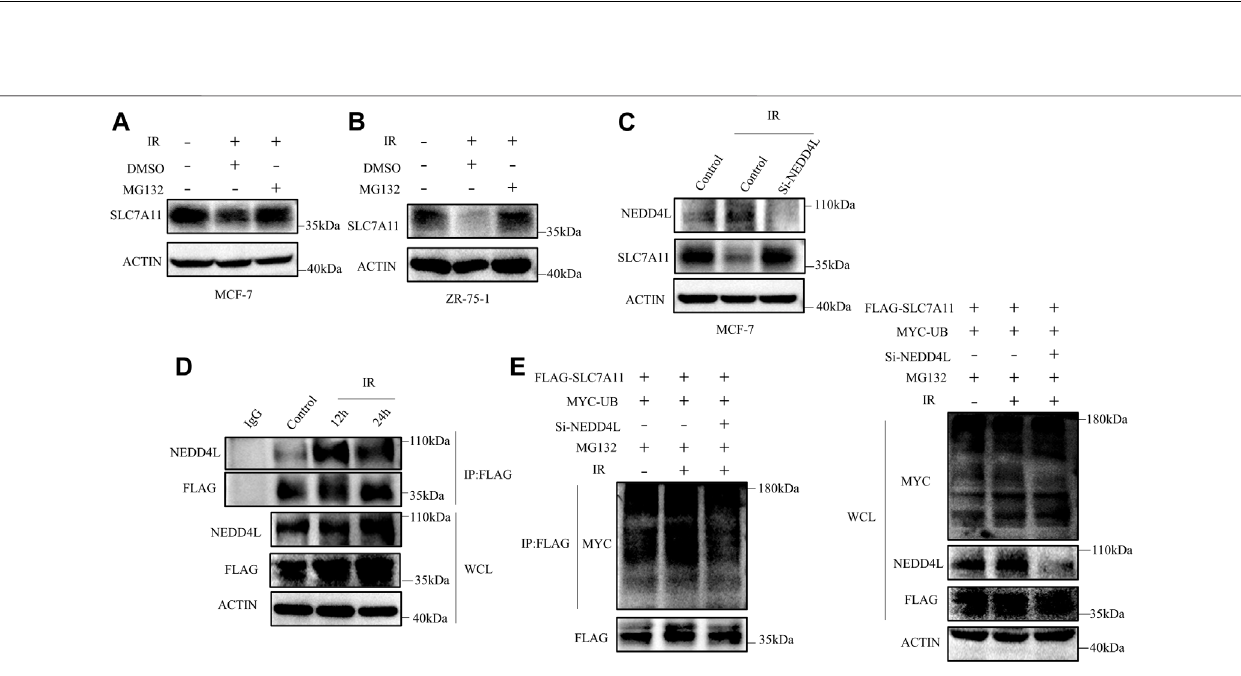
Frontiers in Cell and Developmental Biology |